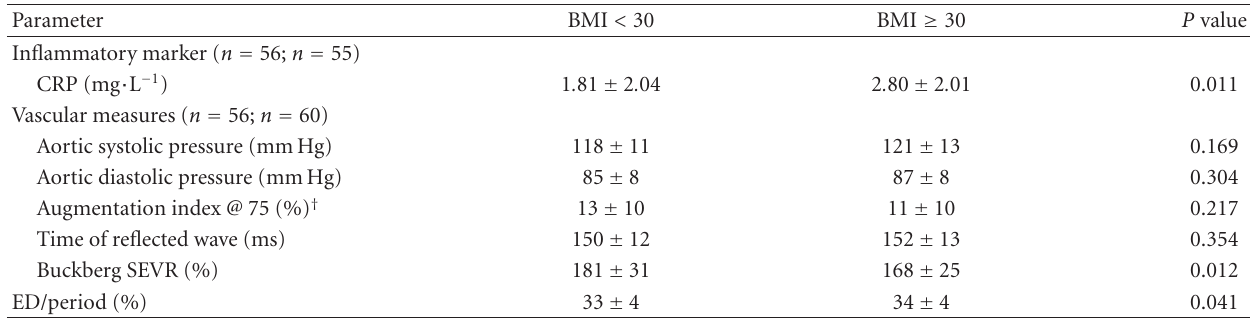
Table 4: Influence of obesity on novel or emerging risk factors.